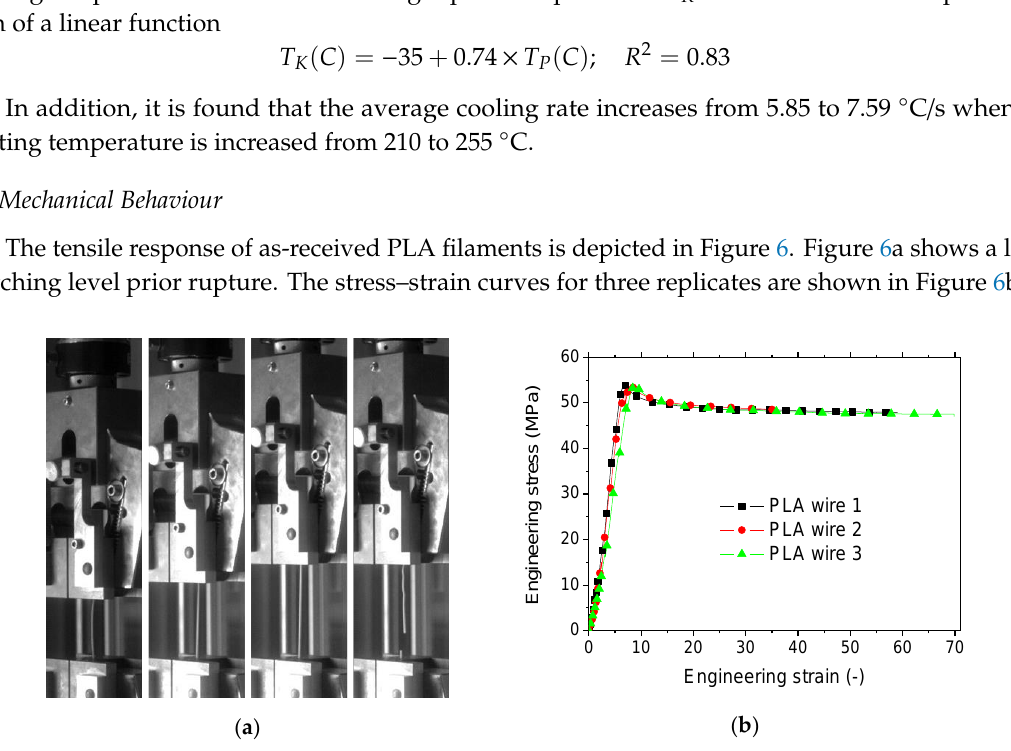
Figure 6. Tensile properties of as-received PLA wire: ( a ) Optical recording of deformed PLA wire under tension; ( b ) Tensile response of three replicates.